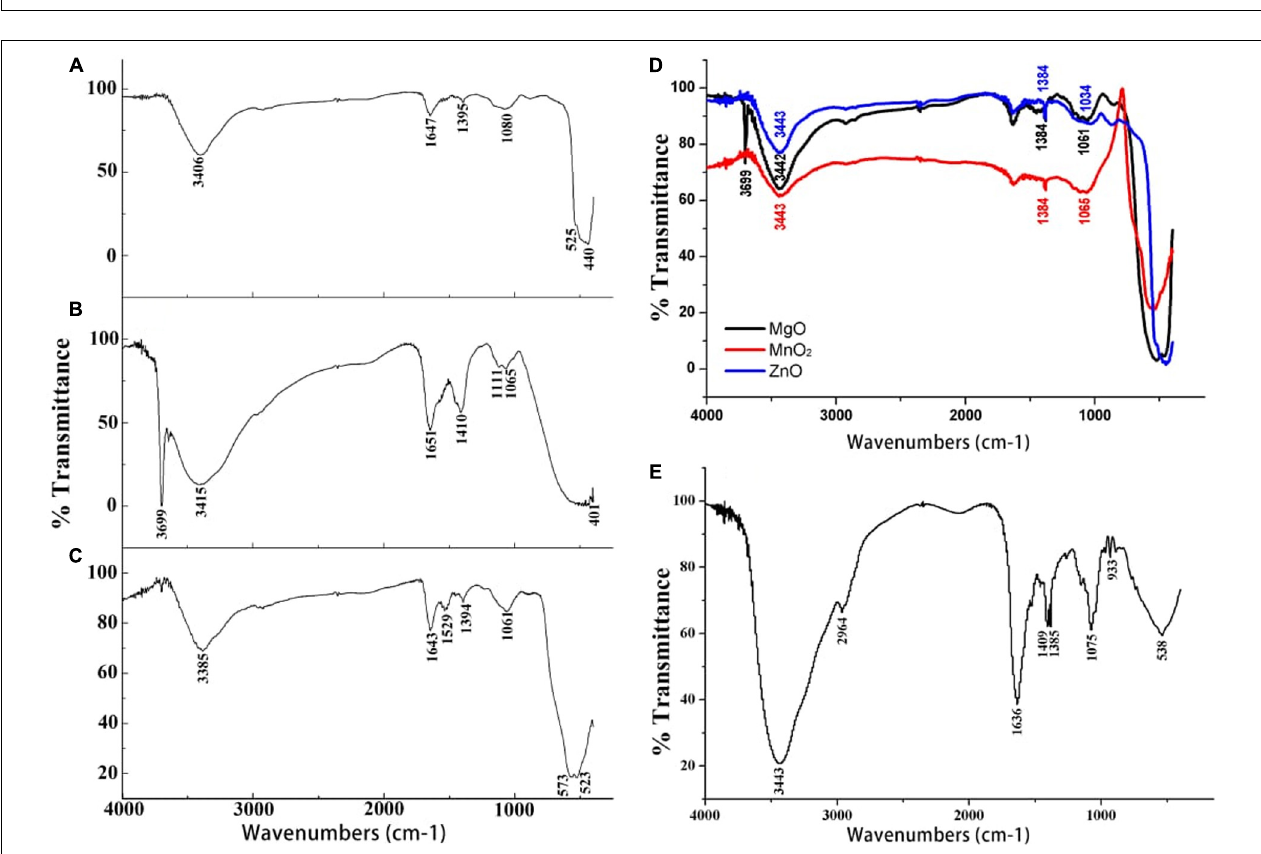
FIGURE 2 | Fourier transform infrared spectra of (A) ZnO nanoparticles (B) MgO nanoparticles (C) MnO 2 nanoparticles (D) Bulk metal oxide of ZnO, MgO, and MnO 2 and (E) Culture filtrate of P. polymyxa strain